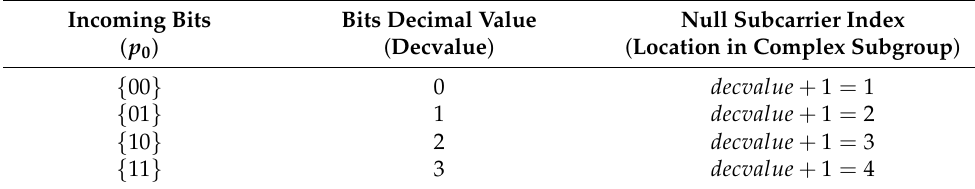
Table 1. The proposed scheme index